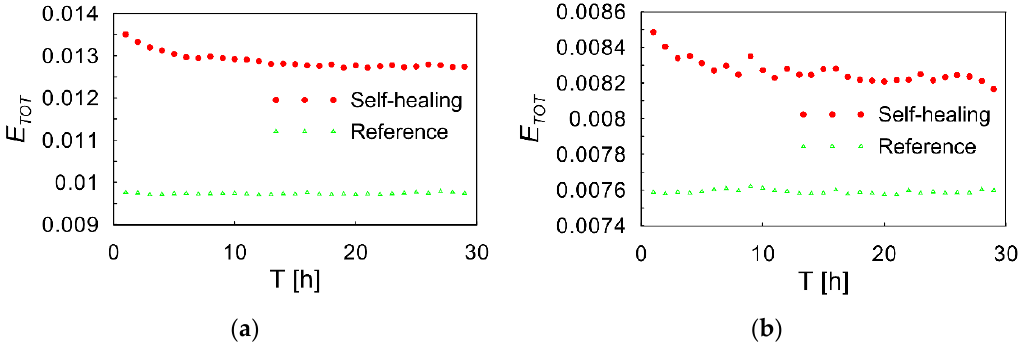
Figure 17. Total damage map energy at impact region: ( a ) 8 J scenario; ( b ) 5 J